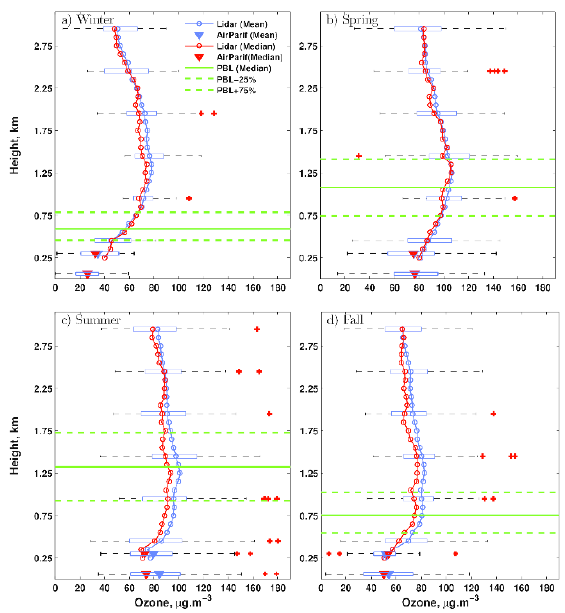
Fig. 2 Seasonal variation (a to d) of vertical pro- files of ozone for the period 2011-2014. Blue (red) curves are the mean (median) of vertical ozone profiles for each season. Blue (red) triangles are the corresponding ozone seasonal mean (median) for in-situ measurements at the surface and at the Eiffel Tower. Whisker boxes limits show the in- terquartile range whereas outliers are showed by red markers. Planetary boundary layers (PBL) heights are represented by a green continuous line while the dashed green lines are for the percentiles 25% and